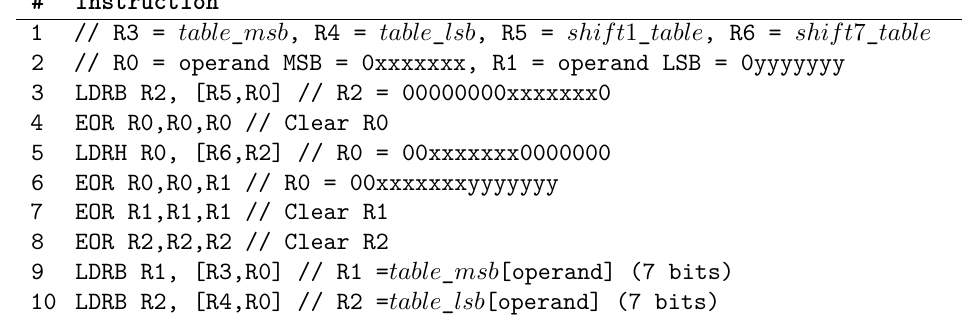
Table 1: Encoded memory access